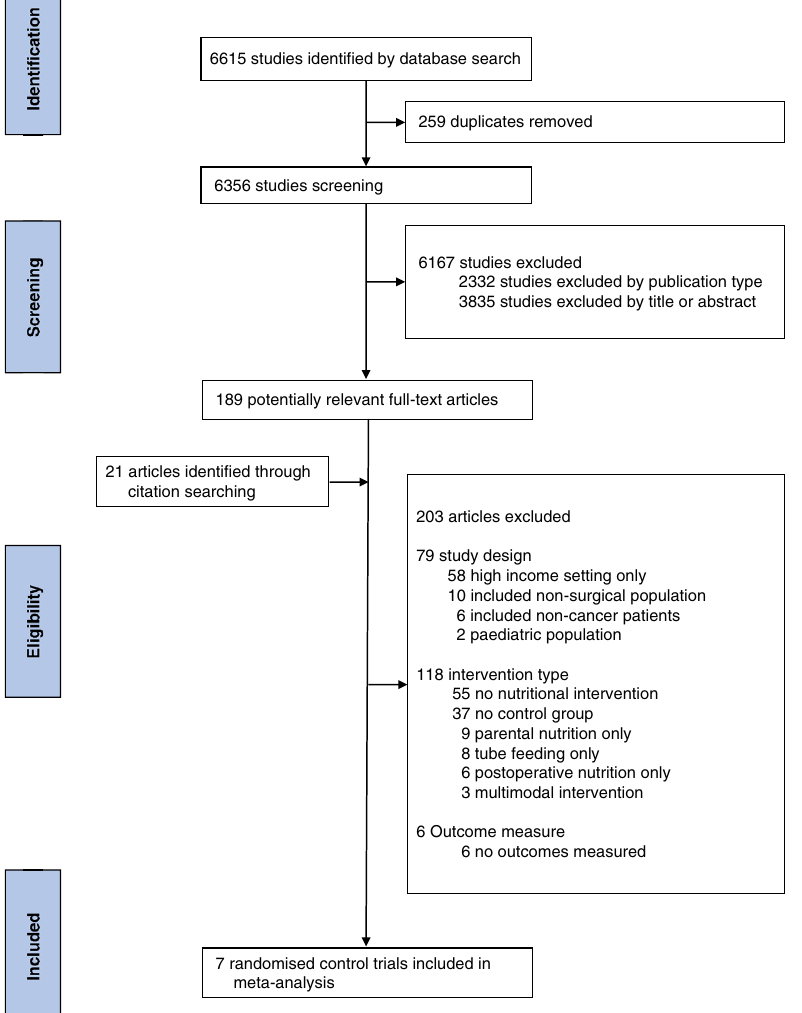
Figure 1. Article selection process.